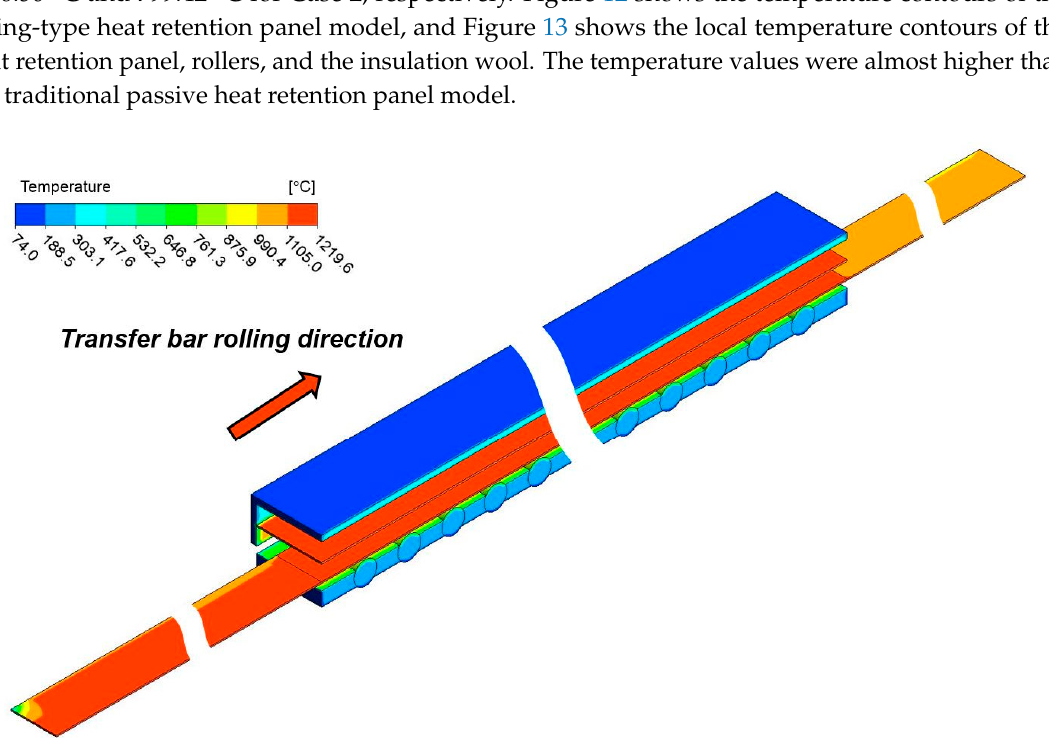
Figure 12. Temperature contours of the acting-type heat retention panel model (Case 1) (Overall view).